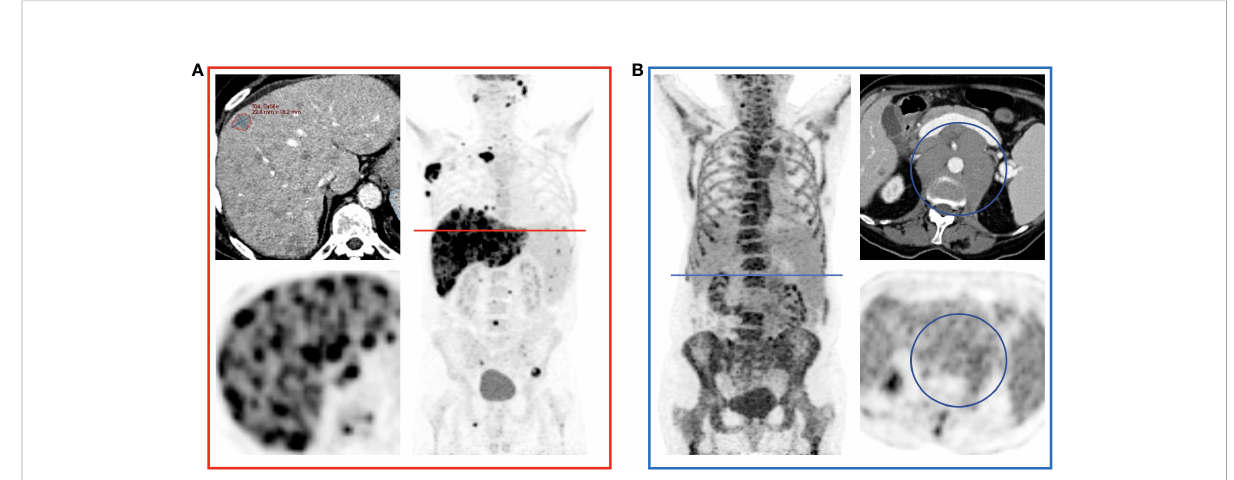
FIGURE 3 Examples of Over- and Underestimation with Metabolic Tumor Burden as Reference. PET/CT images of the patients color-coded in Figure 2 are shown. (A) shows a patient with disseminated hepatic lymphoma manifestation in whom the tumor burden is underestimated by RECIL and Lugano compared to MTV due to the limited number of target lesions. (B) shows a patient after 4 cycles of bridging therapy in whom only small portions of the retroperitoneal lymphoma manifestation are hypermetabolic. Therefore, compared to MTV, a relatively high tumor burden is detected according to the RECIL and Lugano